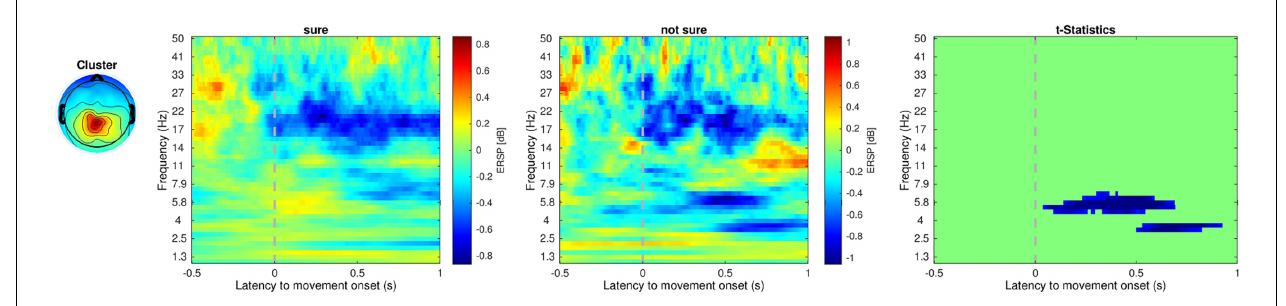
FIGURE 4 | Event-related spectral perturbation of the cluster that showed significant regions within the epoch. Unit is decibel [dB]. The dotted line at 0 s indicates the initiation of the human movement. Cluster 5 includes 21 independent components from six subjects. The power difference (not sure-sure) between about 5–7 Hz was statistically significant.